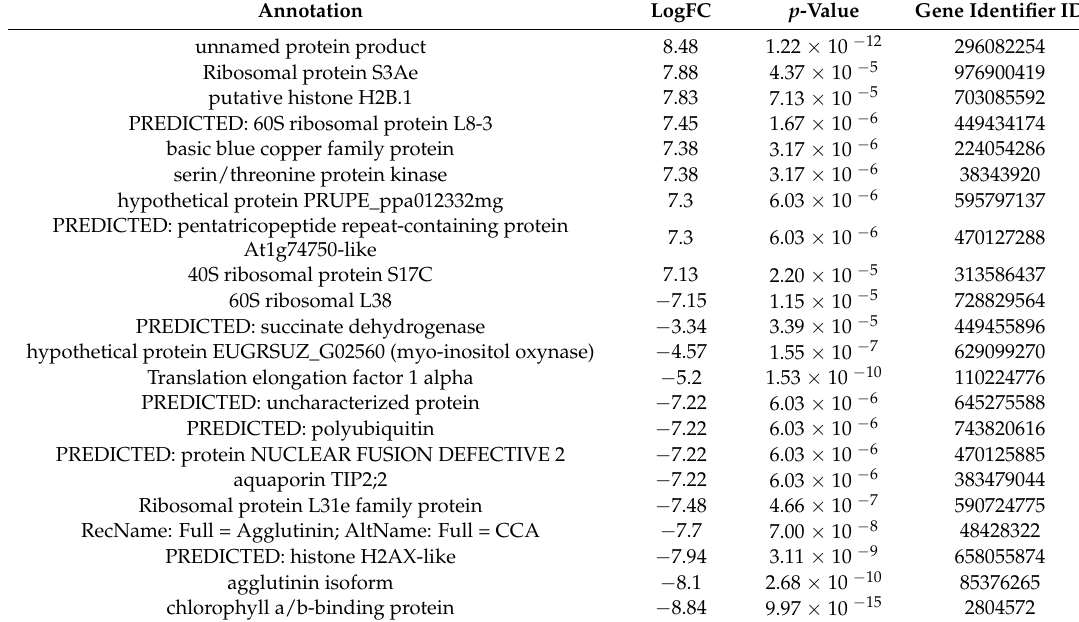
Figure 7. Differentially expressed genes associated with some Molecular Function GO terms identified. Blue nodes represent the MF GO terms while the other nodes represent the associated DE genes. The color of each DE gene node follows an RGB color scale, going from the most down-regulated in red to the most up-regulated in green. Briefly, the results obtained with the differential expression analysis revealed several candidate genes related with bud sprouting, from which a subset is displayed in Table 3. Table 3. Subset of differentially expressed genes identified between the earlier and later stages. A gene with a positive logFC (logarithm fold change) value is (more) expressed in the later stages, while a gene with a negative logFC value is (more) expressed in the earlier stages.